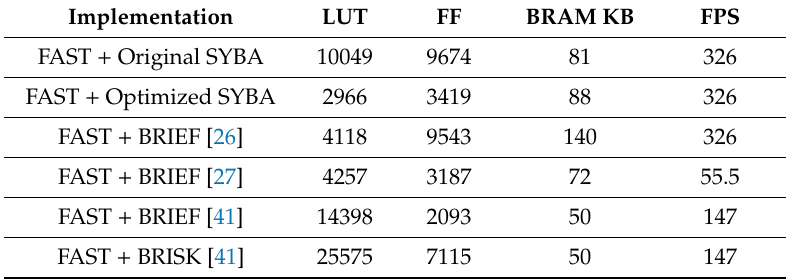
Table 5. Resource utilization of various feature detector and descriptor implementations on FPGAs. These all have several of the same attributes. (1) They all use FAST as the feature detector. (2) They are all using the same hardware, a ZYNQ 7020. (3) They all have the same clock speed, 100